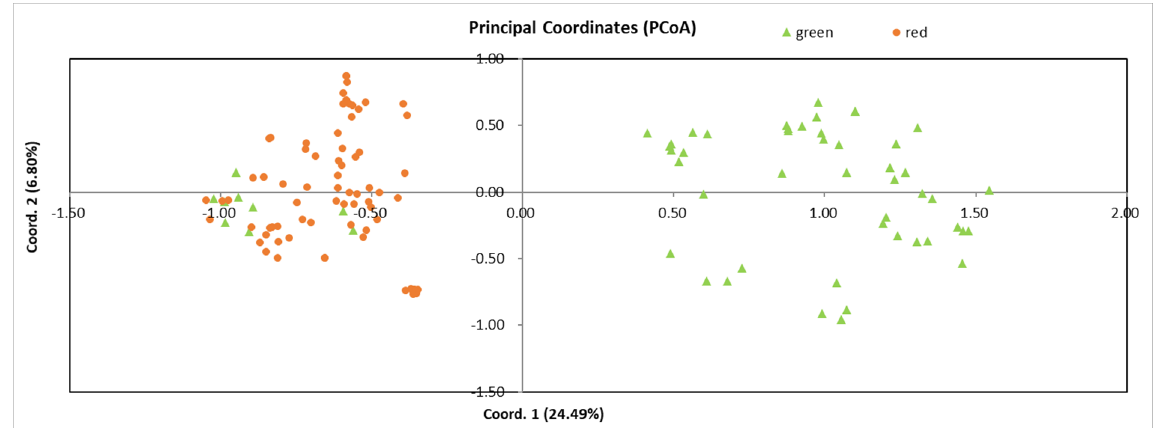
Figure 4. Projection of all samples on the first two principal coordinates based on molecular markers and colored by ecotype. Table 4. The proportion of genetic variance partitioned between ecotypes, among populations within ecotypes, and among individuals within populations as determined by analysis of molecular variance